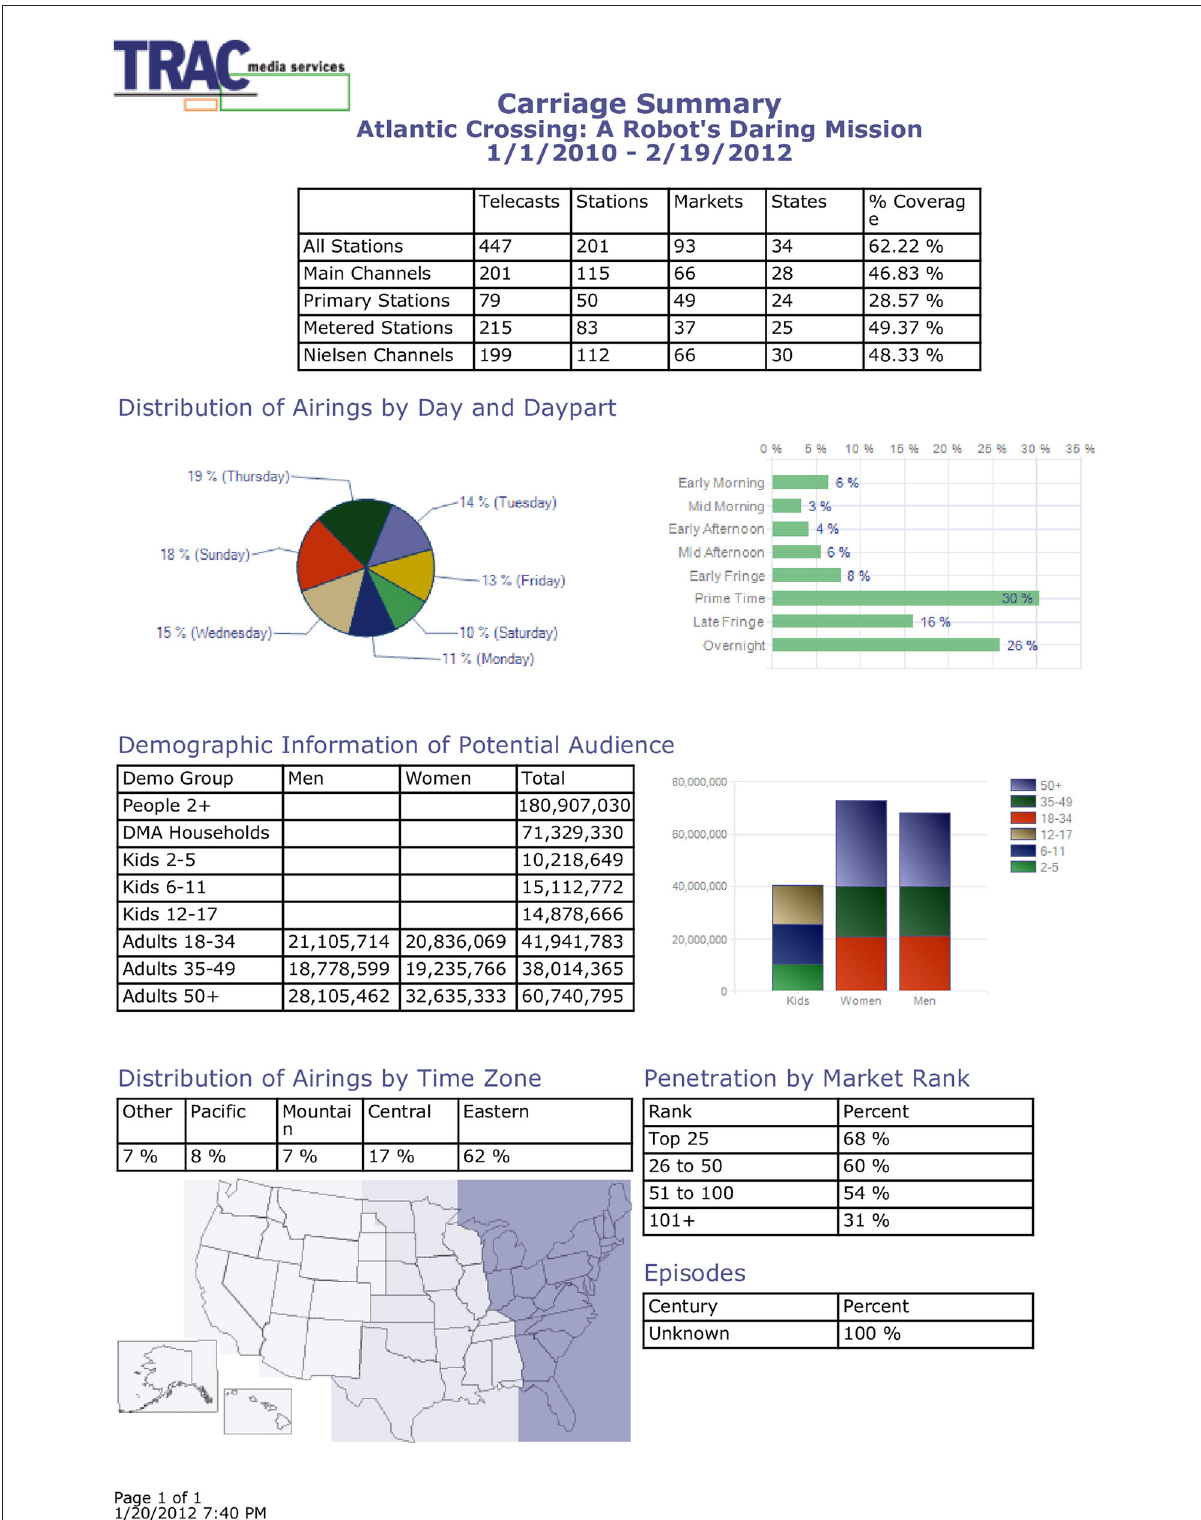
FIGURE5 TRAC Media Services, a leading television audience research firm, prepared a Carriage Summary of the audience reach of Atlantic Crossing: A Robot’s Daring Mission . Results showed that between 2010 to 2012, Atlantic Crossing aired 447 times on PBS stations across the nation reaching a potential audience of 180 million